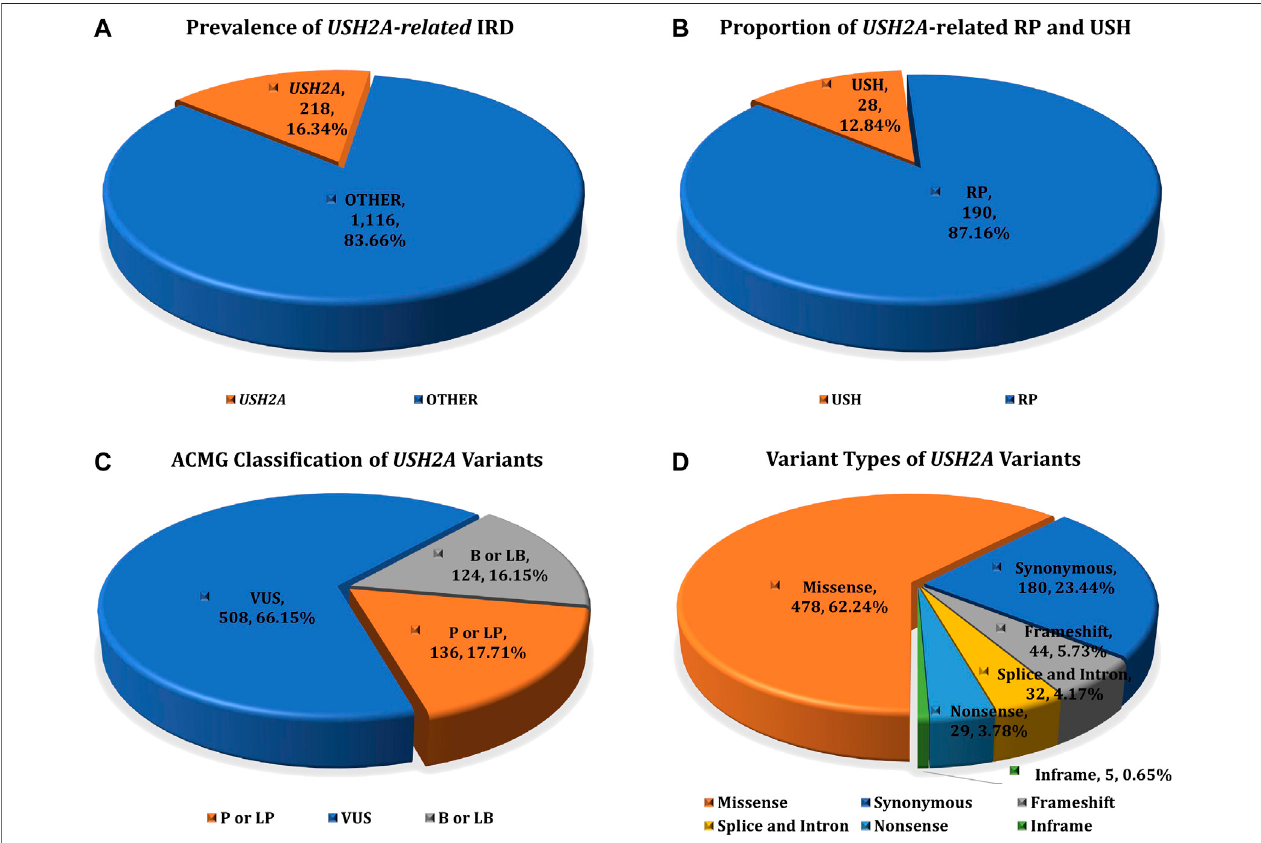
FIGURE 1 | The prevalence of USH2A-IRD and variant category of 768 distinct USH2A variants. (A) Homozygous or compound heterozygous pathogenic mutationsweredetectedin218(16.34%,218/1,334)patientswithUSH2A-IRD; (B) 218geneticallysolvedUSH2A-IRDpatients,including190RPand28USHpatients; (C) ACMG classi fi cation of 768 distinct USH2A variants; (D) Proportion of six types of 768 distinct USH2A sequence variants. P or LP, pathogenic or likely pathogenic; VUS, variants of uncertain signi fi cance; B or LB, benign or likely